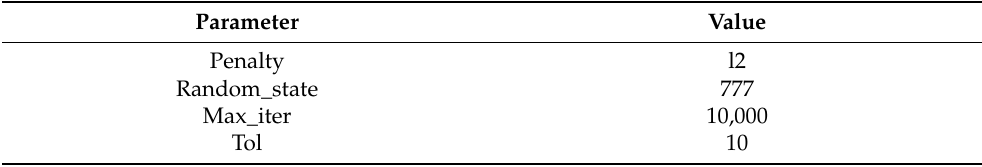
Table 4. Optimized parameter values for the Logistic Regression